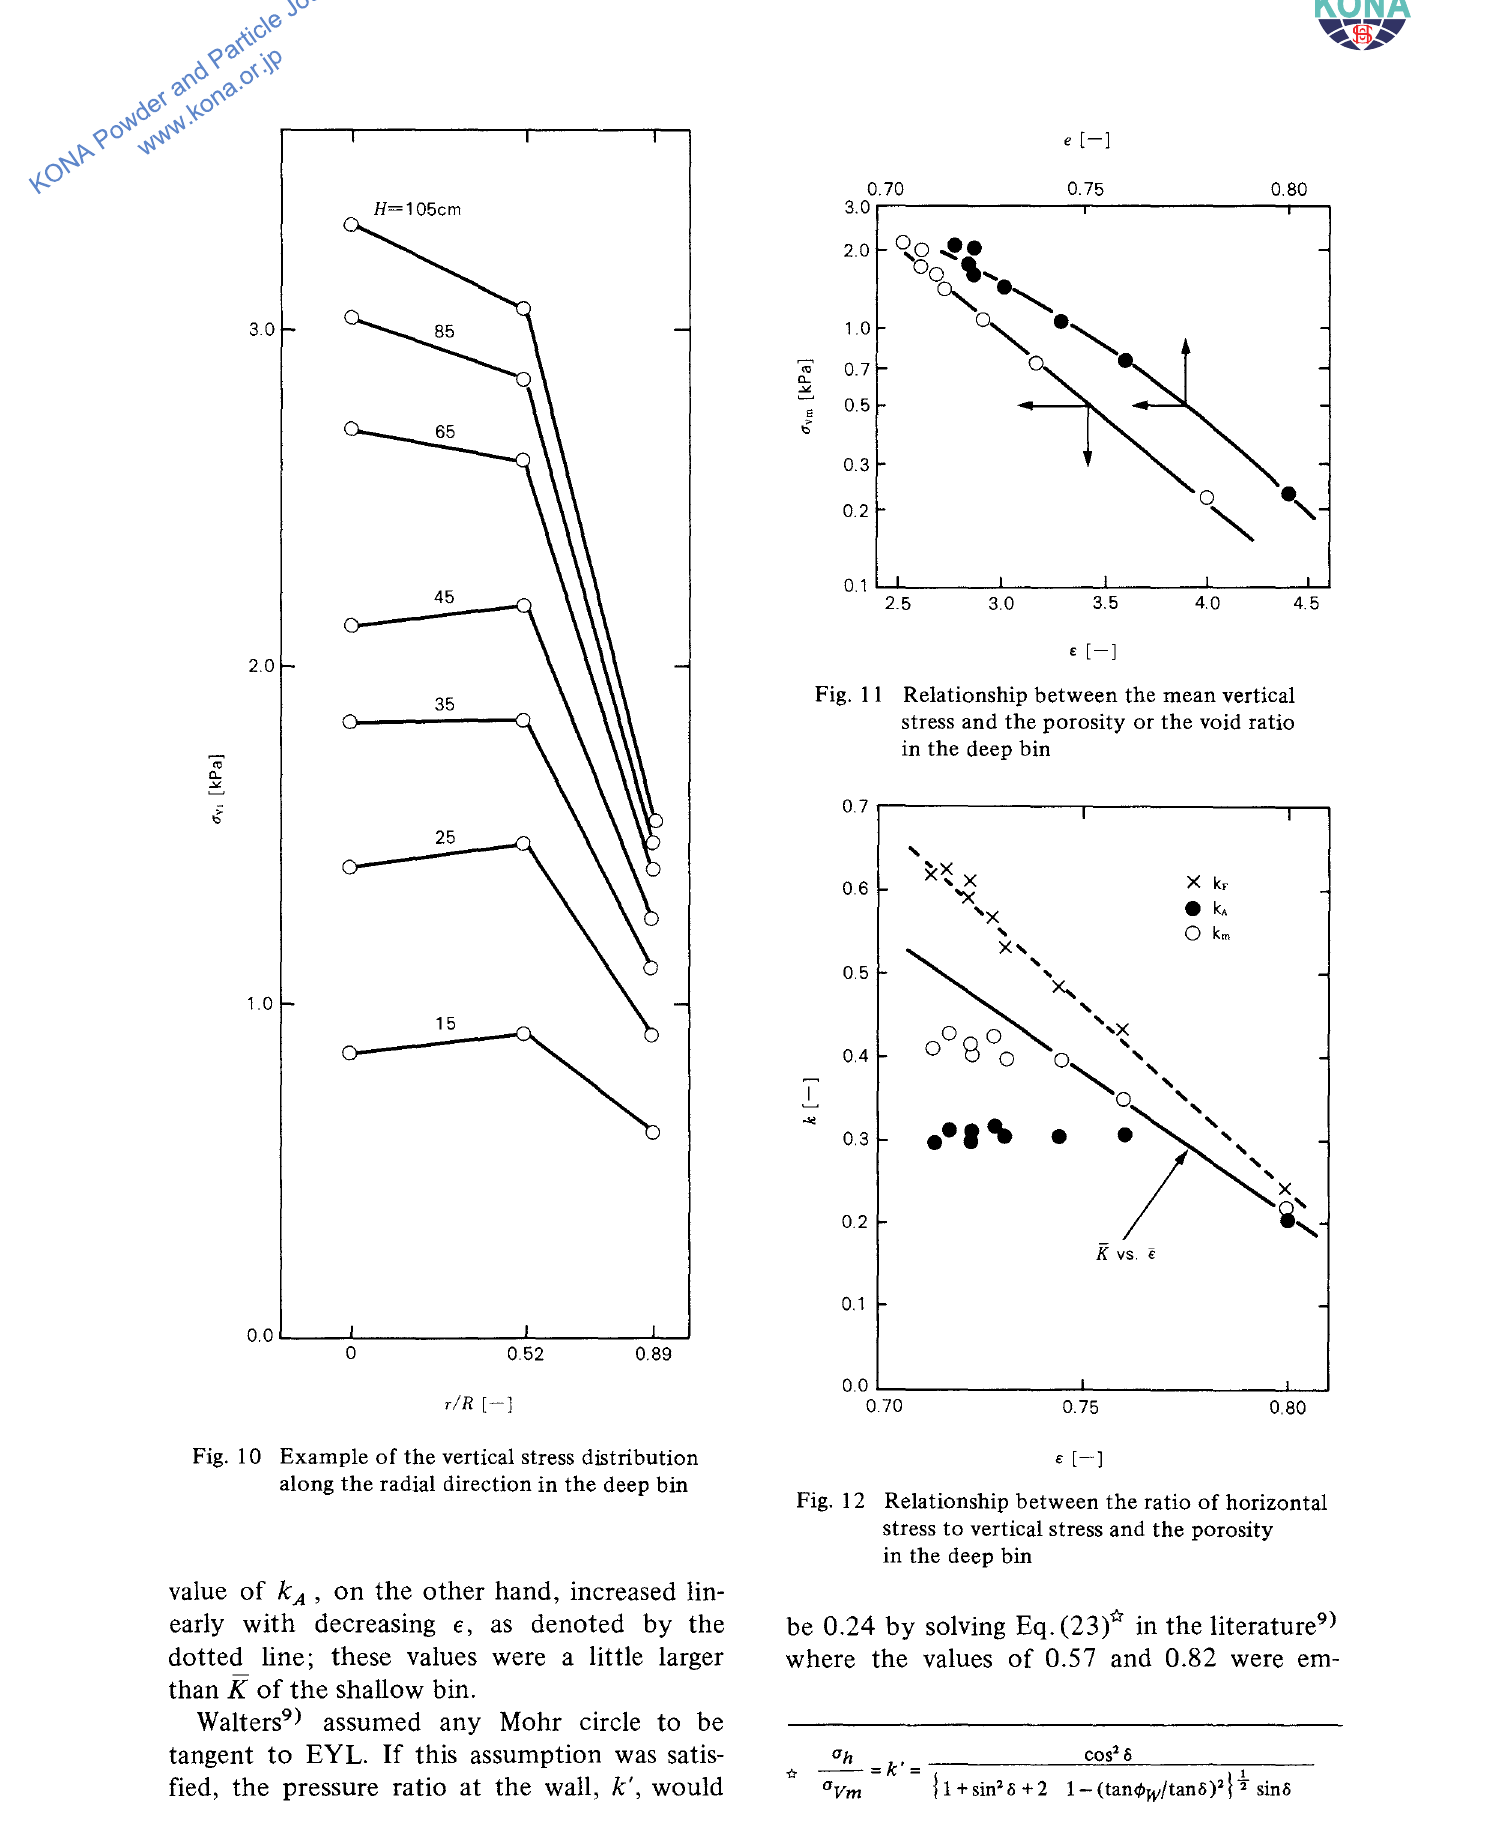
Fig. 12 Relationship between the ratio of horizontal stress to vertical stress and the porosity in the deep